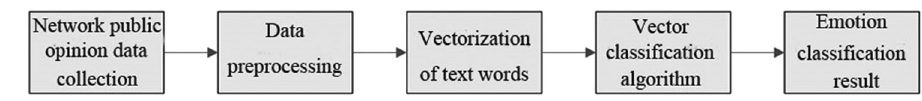
Figure 1: The basic model of emotional tendency calculation in online public opinion.